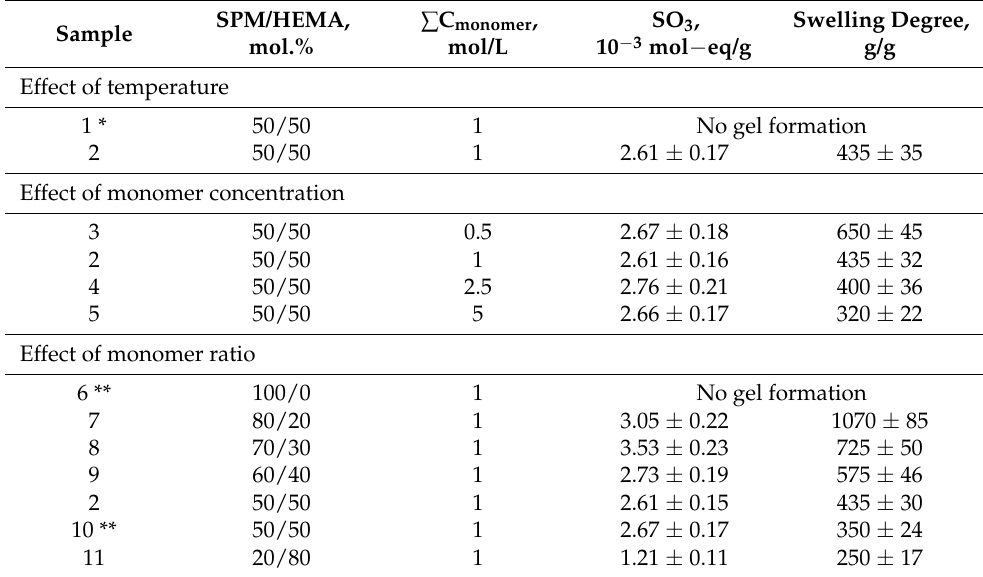
Table 1. Composition of the reaction system for the synthesis of P(SPM − HEMA) cryogels and cryogel